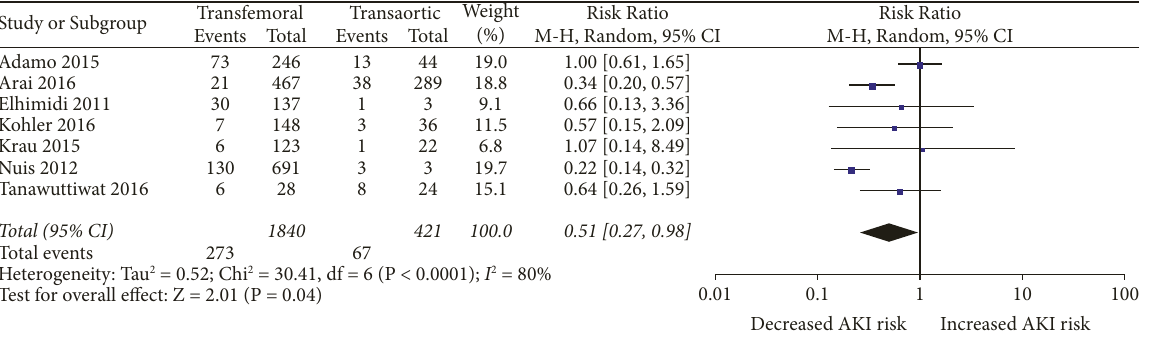
Figure 4: Forest plot comparing the risk of developing AKI between TA and TAo TAVR approaches. Table 1: Table showing a summary of crude RRs of each assessed predictor for AKI among patients undergoing TAVR. Factor